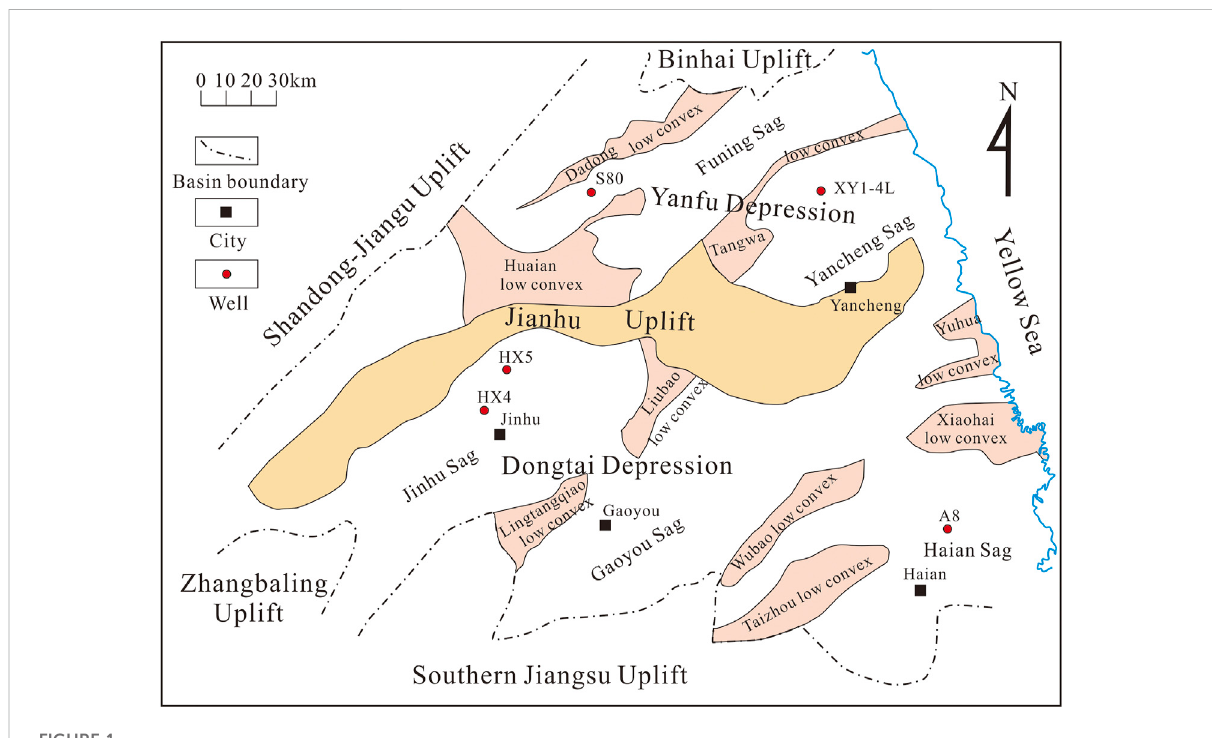
FIGURE 1 Geological setting of the Subei